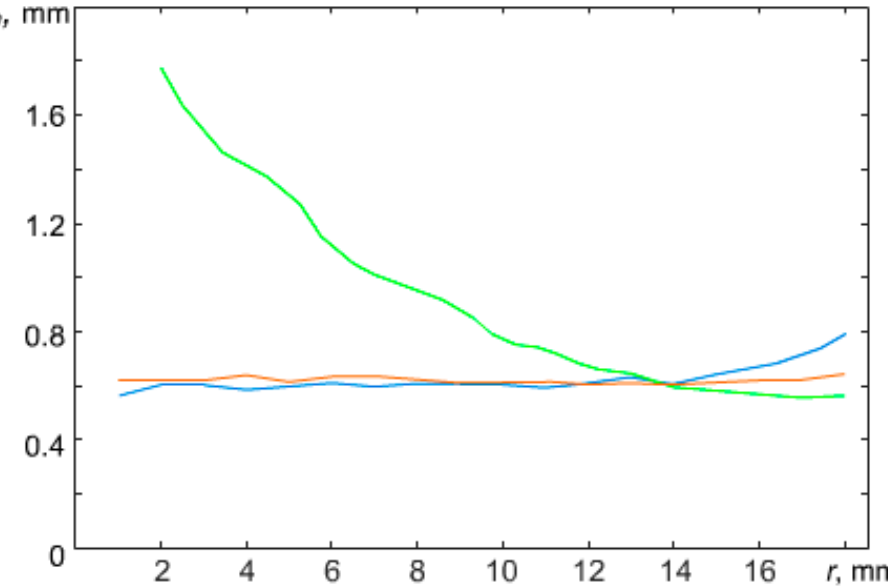
Figure 3. A dependence of the radial distribution of the average interparticle distance in the quasi- two-dimensional structure in an argon plasma of RF discharge at P = 5 Pa and various values of discharge power W: blue curve is for W = 4.4 W; red is for 6.9 W; green is for 16.7